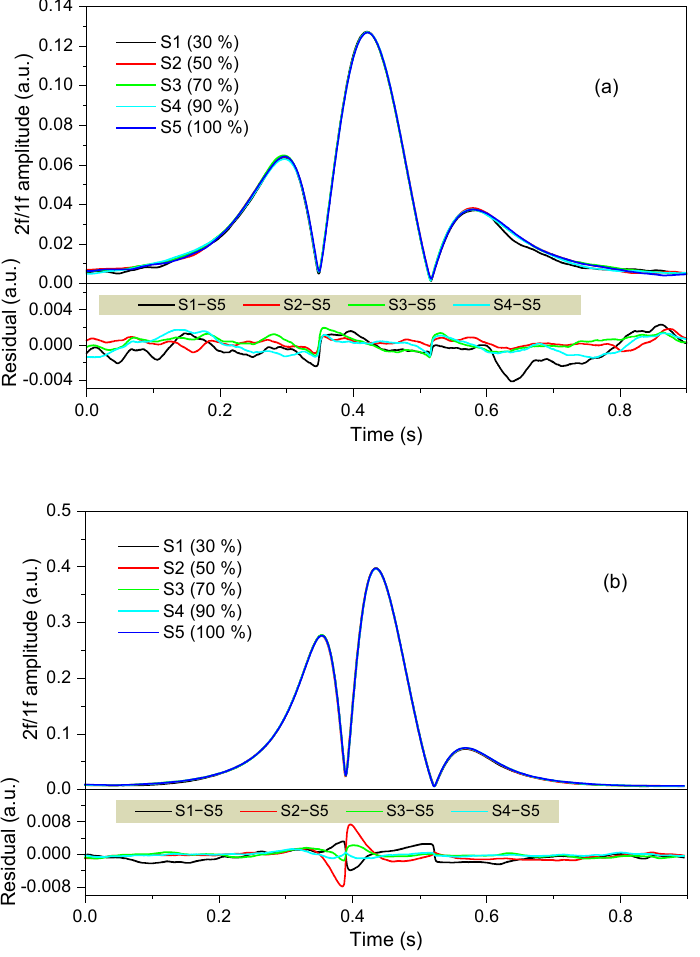
Figure 6. 2 f /1 f spectral profiles with different laser intensities coupled on the same photodetector for ( a ) 500-ppm CH 4 and ( b ) 500-ppm C 2 H 2 diluted in N 2.